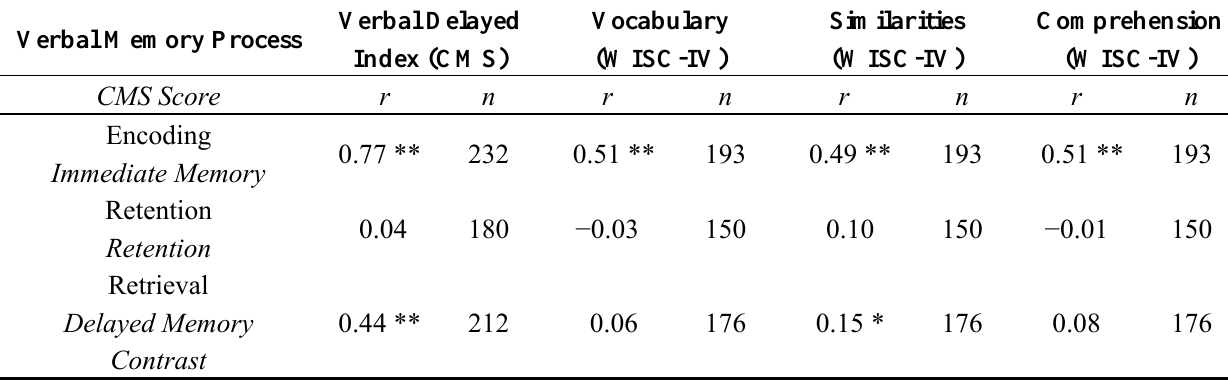
Table 5. Correlations between discrete verbal memory processes, overall verbal memory performance and measures of verbal